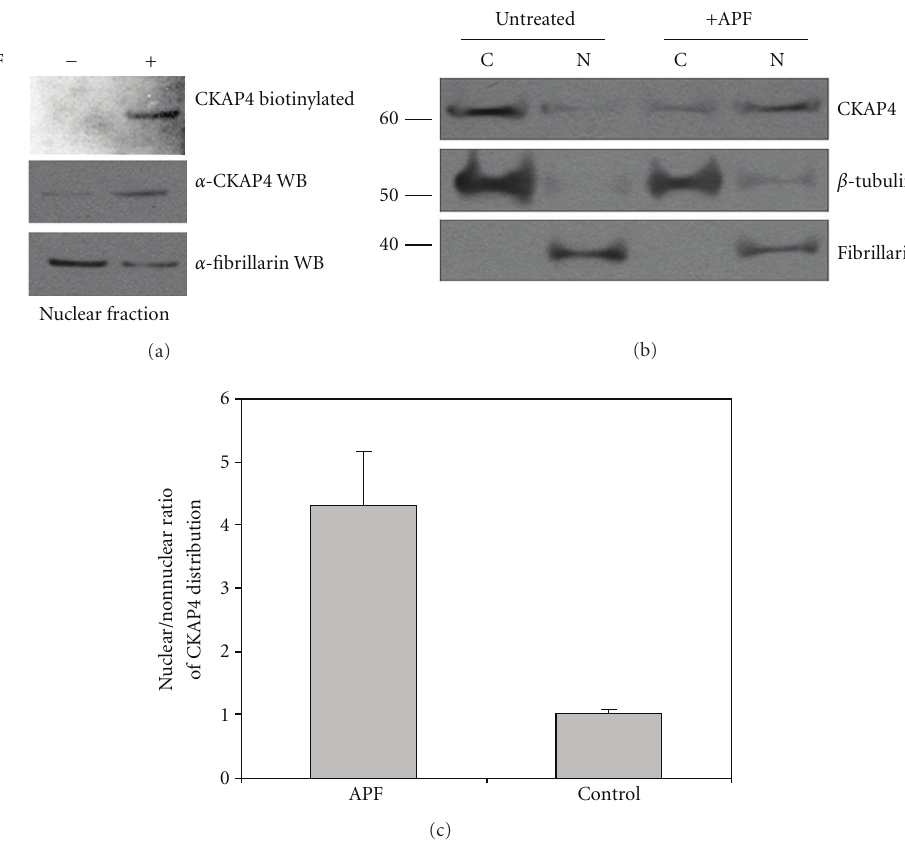
Figure 2: Surface-labeled CKAP4 translocates from the plasma membrane into the nucleus following APF exposure . (a) HeLa cell-surface proteins were labeled with Sulfo NHS-biotin as described in Section 2. Following exposure to 20nM APF for 24 hours (or no treatment), the cells were harvested and the nuclear protein fraction was isolated (Pierce NE-PER), separated by SDS-PAGE, and transferred to nitrocellulose. The membrane was then probed with streptavidin-HRP (1:5000; Pierce) to bind biotinylated proteins, and the signal was detected by ECL (Pierce). Following detection of the biotinylated proteins from the nucleus, the (streptavidin) HRP on the membrane was inactivated by incubating the blot in PBS containing 3% H 2 O 2 and 1% sodium azide. The same membrane was then reprobed with antibodies to CKAP4 (“anti-CLIMP-63”, diluted 1 :1000, Alexis Biochemicals) and fibrillarin (a nuclear marker and loading control; Abcam; diluted 1:1000). (b) HeLa cells were treated with APF (20nM) for 24 hours, which resulted in a significant increase in the abundance of CKAP4 in the nucleus compared to control samples. Treated cells were harvested and the nuclear and cytosolic fractions were isolated and separated by SDS-PAGE as described in Section 2. Protein expression was analyzed by Western Blotting with antibodies for β -tubulin (diluted 1 :1000, Abcam; loading control for the nonnuclear fraction), CKAP4 (“anti-CLIMP-63”, diluted 1:1000, Alexis Biochemicals), and fibrillarin (diluted 1 :1000, Abcam; loading control and specific marker for the nuclear fraction), and then with an HRP-conjugated anti-mouse secondary antibody (1:20000; ThermoFisher Scientific). The proteins were detected by ECL (Pierce) with multiple exposures to film. The integrated density of the bands on the film was measured using ImageJ. Exposure times were controlled to ensure that the signals on film were not saturated. (c) The nuclear/cytosolic ratio represents the relative distribution of CKAP4 in the nuclear versus cytosolic fractions extracted from cells treated with or without APF. CKAP4 abundance in the APF-treated and control samples were normalized for loading to β -tubulin for the nonnuclear fractions and to fibrillarin for the nuclear fractions. The nuclear/cytosolic ratio for CKAP4 in the APF and control samples was determined from these normalized values. The standard deviation describes the variability among the normalized, nuclear, and cytosolic ratios from three independent experiments. A two tailed, paired t -test of the two data arrays (plus APF and control) indicate that the di ff erence between these ratios is significant ( P = 0 . 01; n = 3). Cells treated with APF stop dividing, so the 10cm dishes containing control and APF treated cells contained fewer cells (and protein) at the end of the experiment, normalizing the CKAP4 signals to loading controls corrected for this disparity. Fibrillarin is a well-characterized nuclear marker that is also known to localize to nucleoli. The data shown are representative of four independent